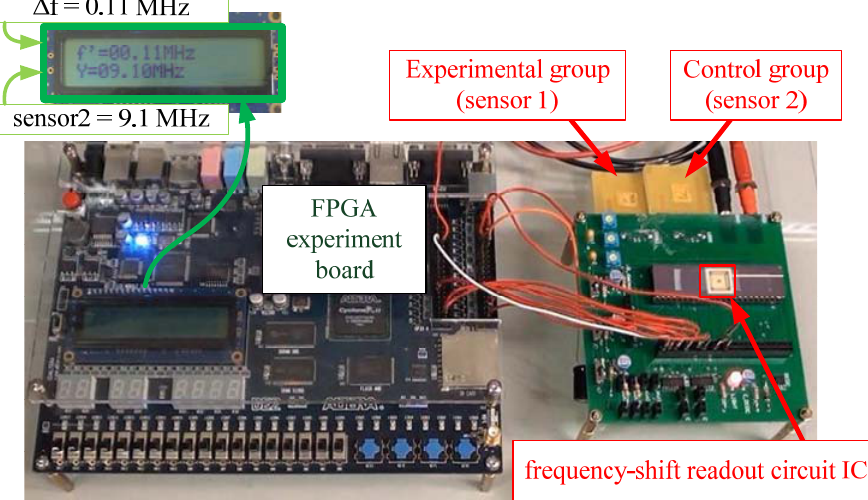
Figure 18. Prototype of the protein concentration measurement